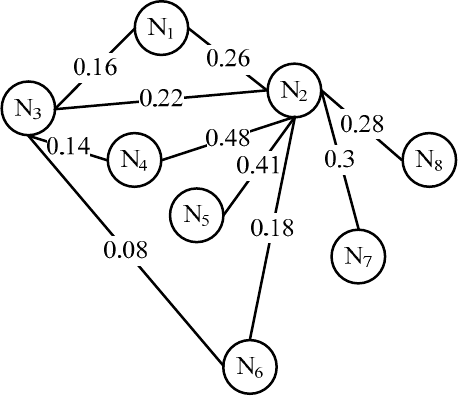
Figure 7. Needs-related undirected graph.